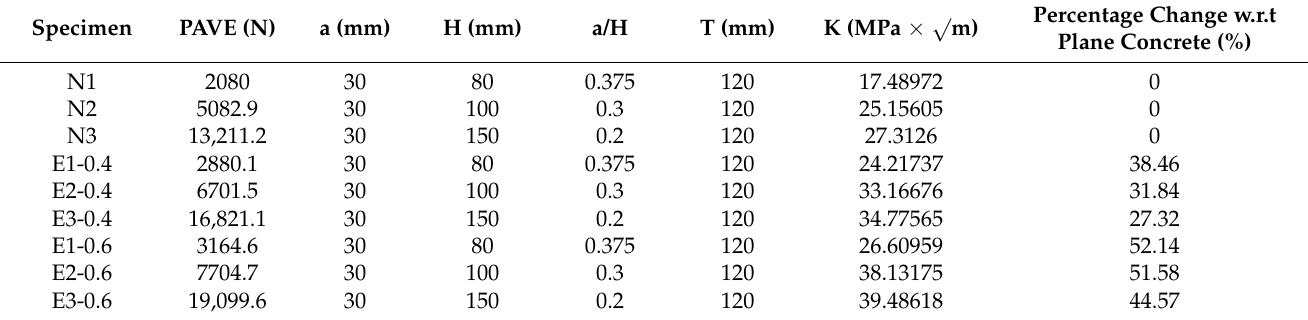
Table 7. Critical stress intensity factor for different thicknesses H .